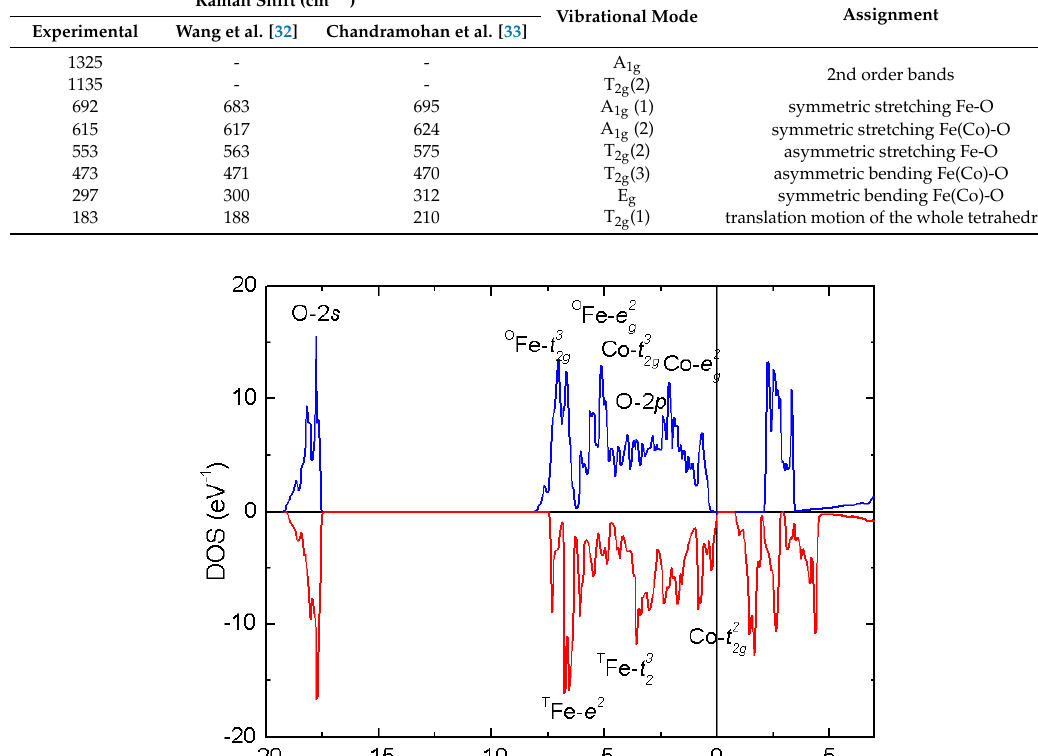
Figure 9. Density of states (DOS) around the Femi level E F of the inverse spinel structure, Fe 3+ [Fe 3+ Co 2+ ] O 4 . The majority spin (blue, positive): Co, Fe(oct)- t 2g3 e g2 . Minority spin (red, negative): Fe(tet)- e 2 t 23 , Co(oct)- t 2g2 .